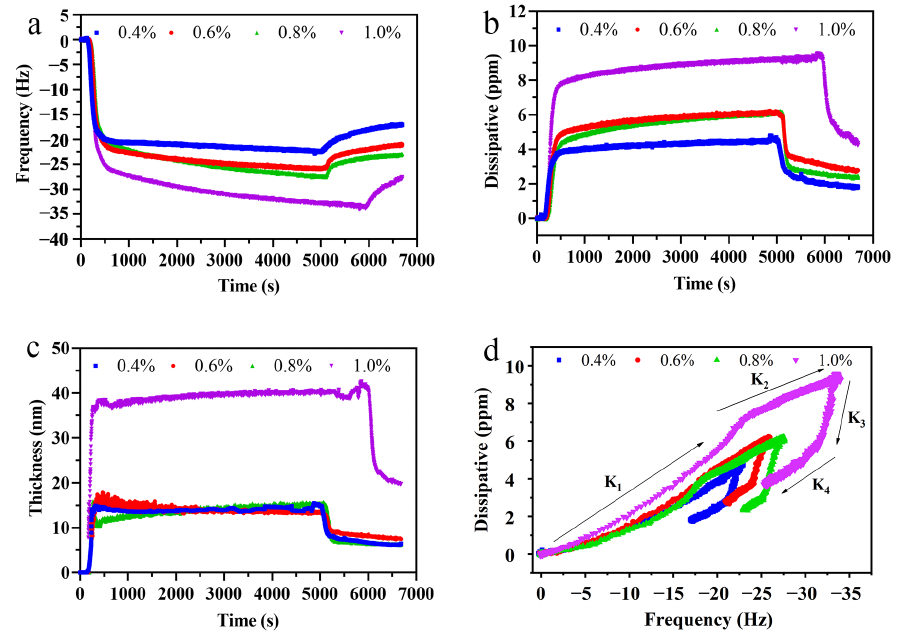
Figure 4. The frequency ( a ), dissipative ( b ) and thickness ( c ) during the adhesion and washing at the MCT-coated sensors; D-f plots ( d ) during adhesion and washing processes (K 1 , K 2 , K 3 , and K 4 were the slopes at four different phases, respectively).